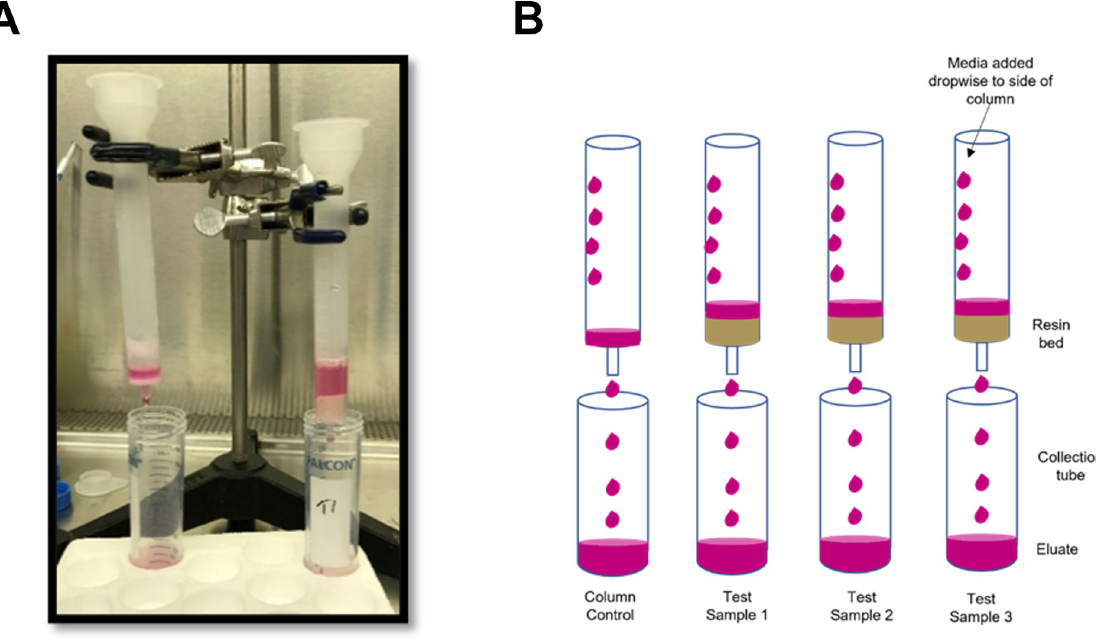
Fig 1. Experimental set-up. a. Set-up of columns in clamp/ ring stand. b. Schematic diagram.